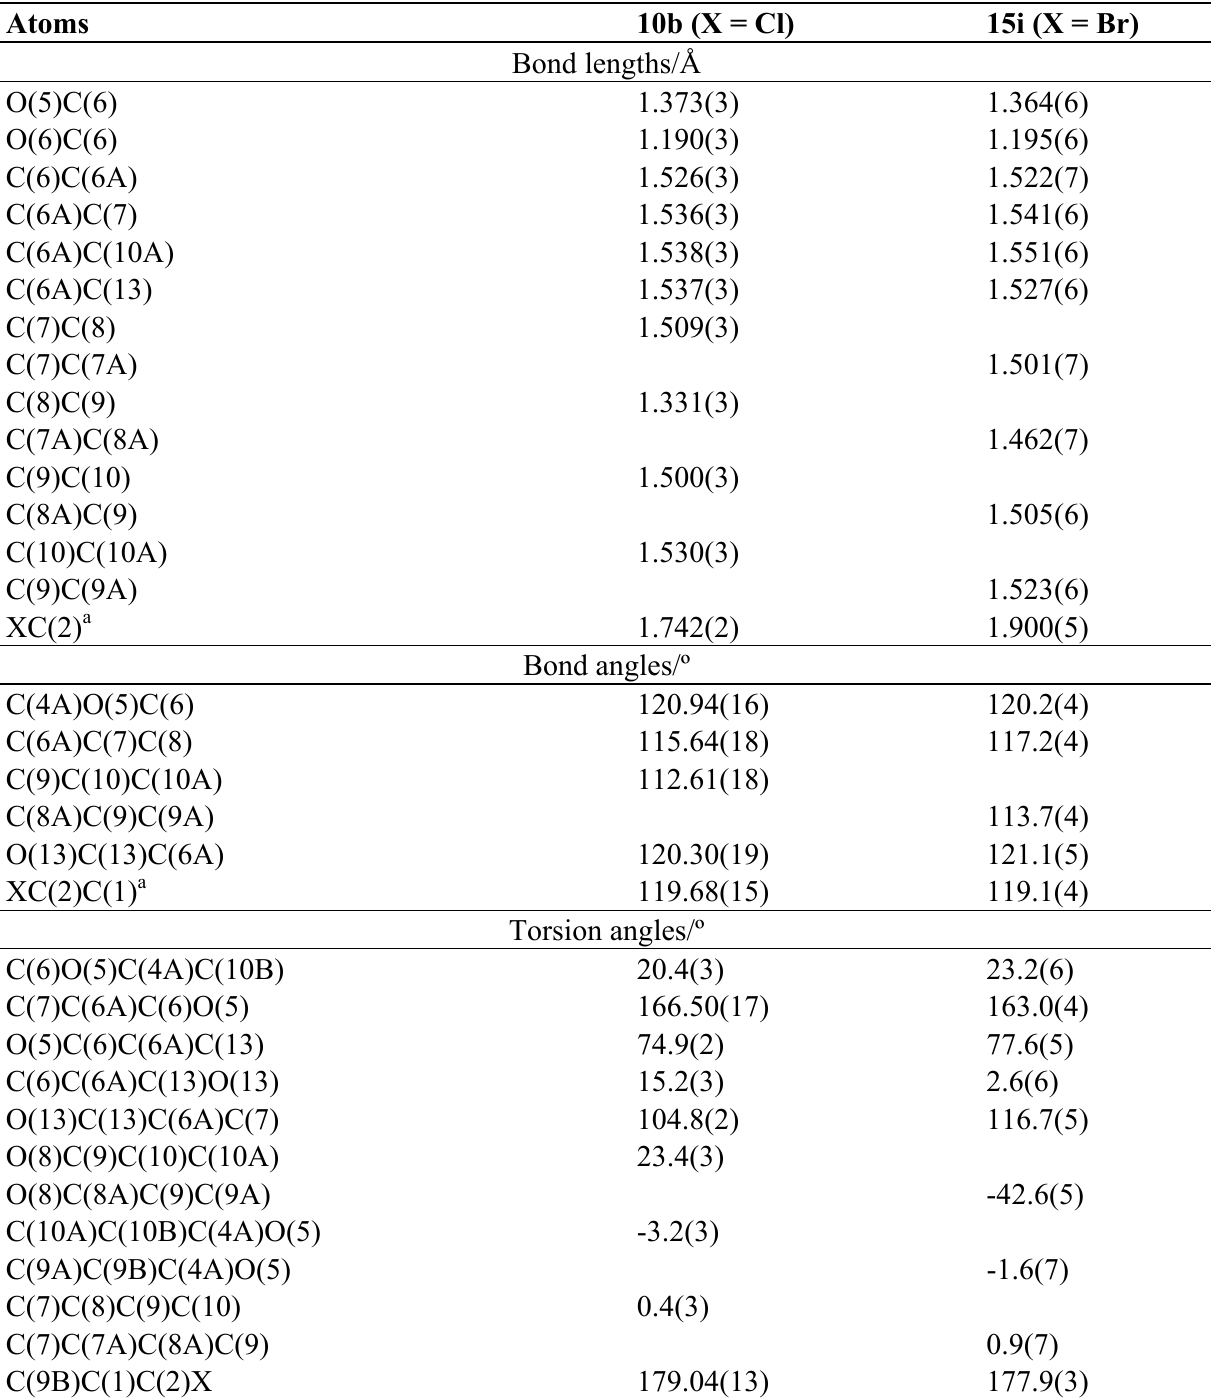
Table 1. Selected bond lengths and angles from X-ray data of compounds 10b and 15i . Atoms 10b (X =